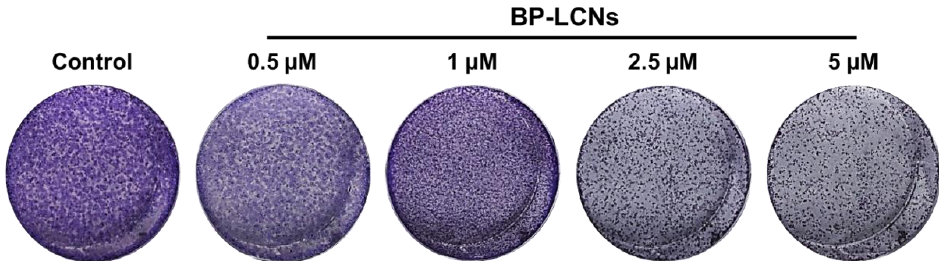
Figure 10. Effects of BP-LCNs on colony formation of A549 cells. A549 cells, grown in a 6-well plate, were incubated at 37 °C for 2 weeks in the absence or presence of BP-LCNs (final concentration of 0.5, 1, 2.5, or 5 µM). They were fixed with formaldehyde, then stained with 0.4% v / v crystal violet staining solution. Images of individual wells were captured from bottom of the plate. The images are representative of 3 independent experiments. Abbreviation: BP-LCNs, berberine – phytantriol liquid crystalline nanoparticles.